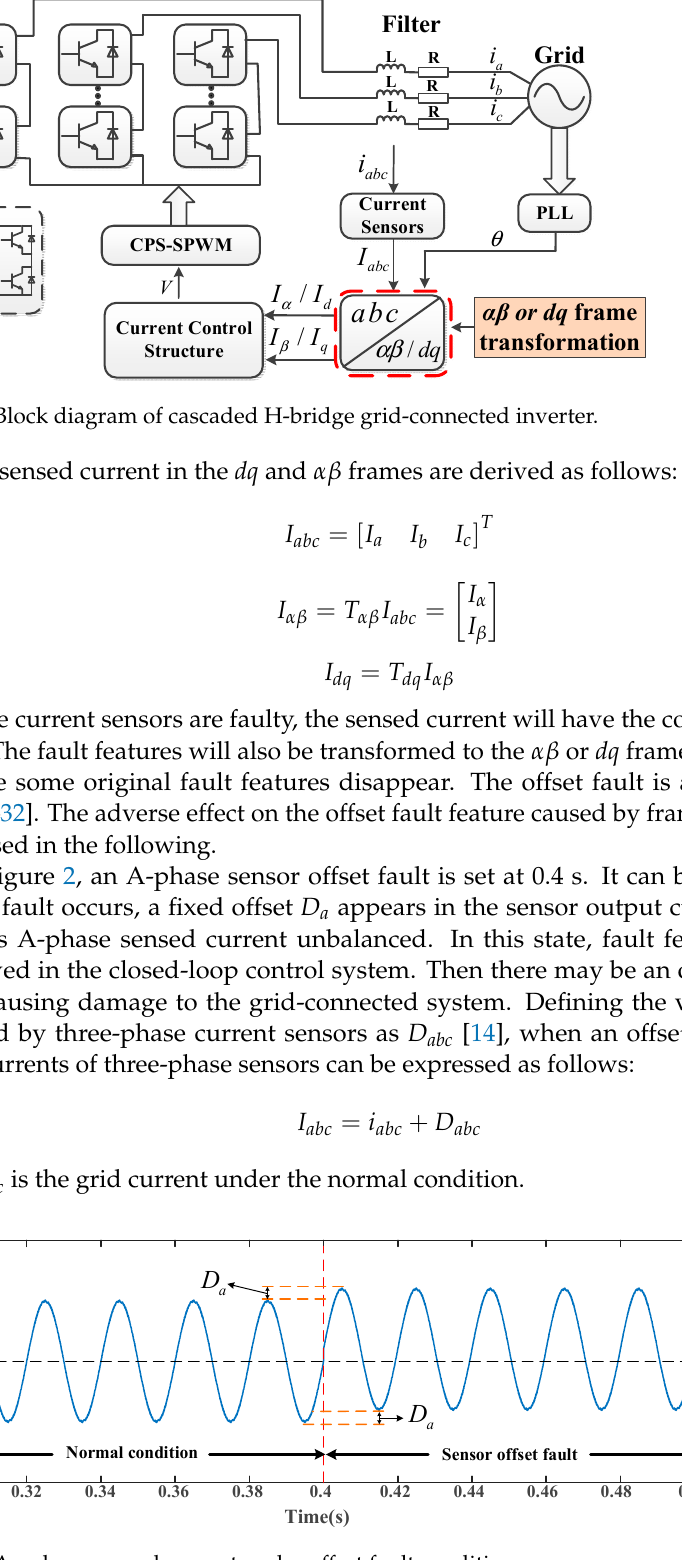
Figure 2. A − phase sensed current under offset fault condition.